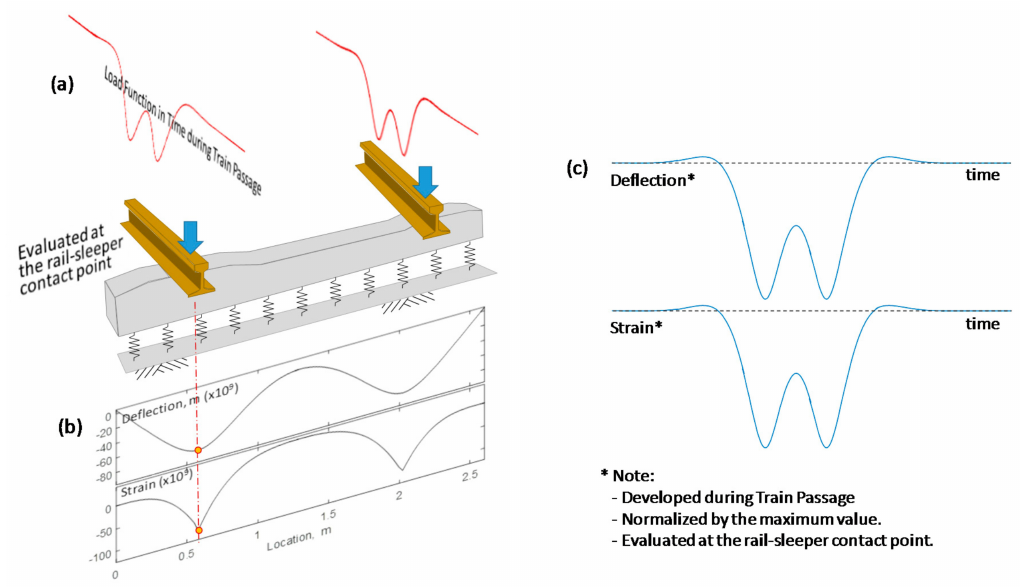
Figure 3. Relationships between strain and deflection: ( a ) load function in time during train passage; ( b ) deflection and strain functions along the sleeper; ( c ) time-histories of deflection and strain developed during train